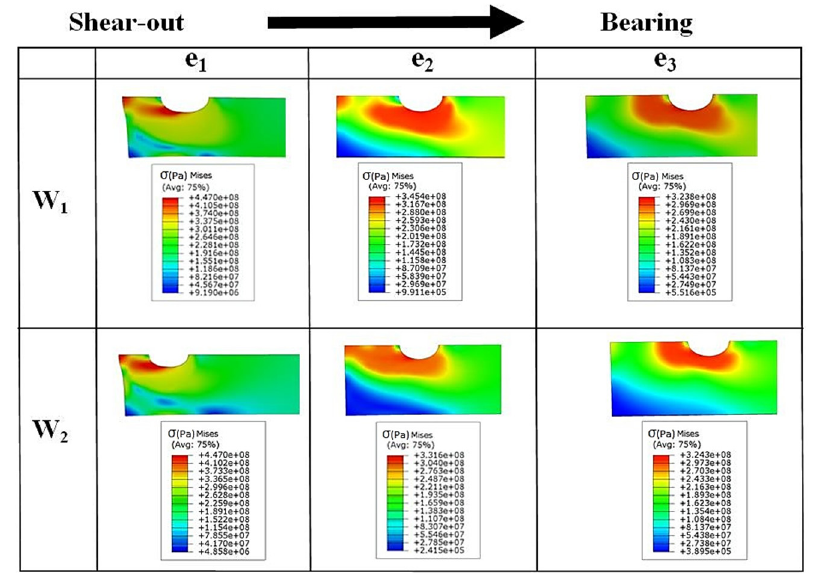
Figure 8. Von Mises stress (Pa) contours in the middle plate of single bolt joint specimens with different widths ( W 1 and W 2 ) and edge distances ( e 1 , e 2 , and e 3 ).